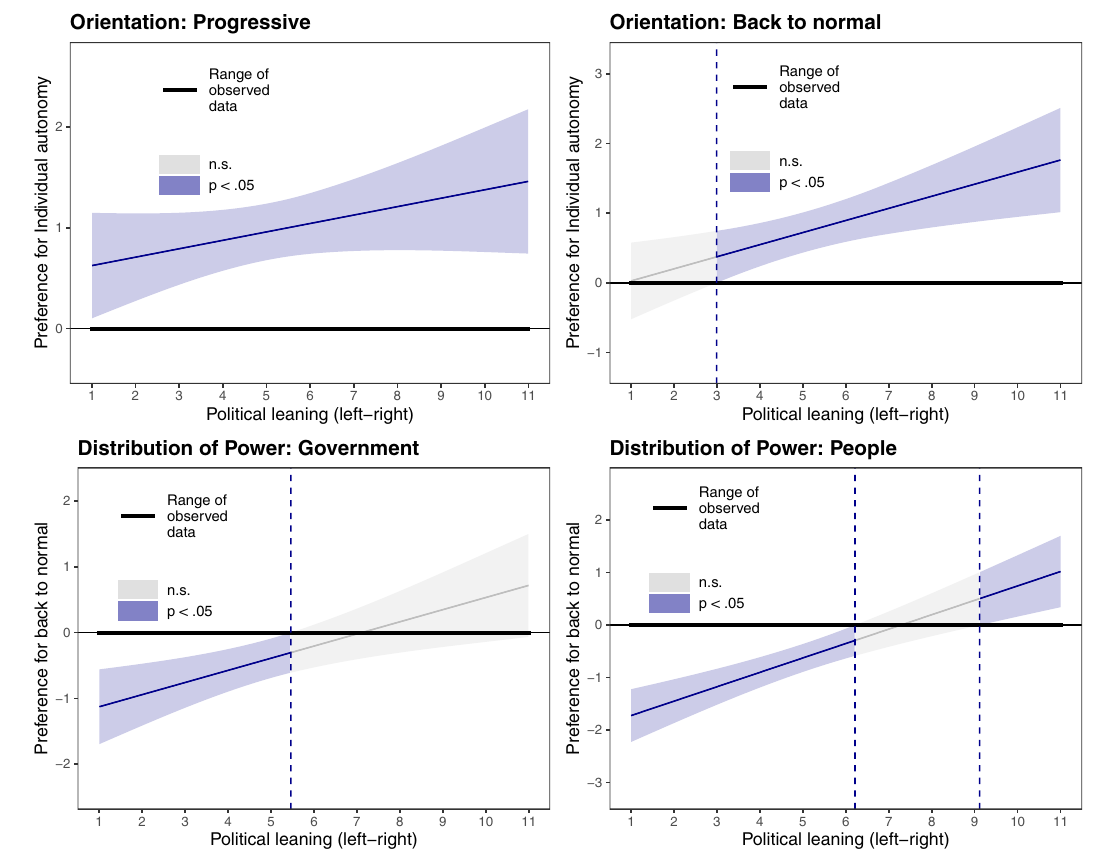
Fig. 7 Floodlight analysis in Experiment 2. In each panel, people ’ s preferences for the future (expressed as difference score between two scenarios) are expressed as a function of political leaning. The top row of panels shows preferences for individual autonomy and a return of power to the people (as opposed to power being retained by governments) for the progressive (left) and back to normal scenarios (right). The bottom row of panels shows preferences for a return to normal (as opposed to a progressive future) when power is retained by government (left) or returned to people (right). In each panel, purple regions identify the range of political leanings where people ’ s preferences for one over the other scenario are signi fi cant. Gray regions are indeterminate.